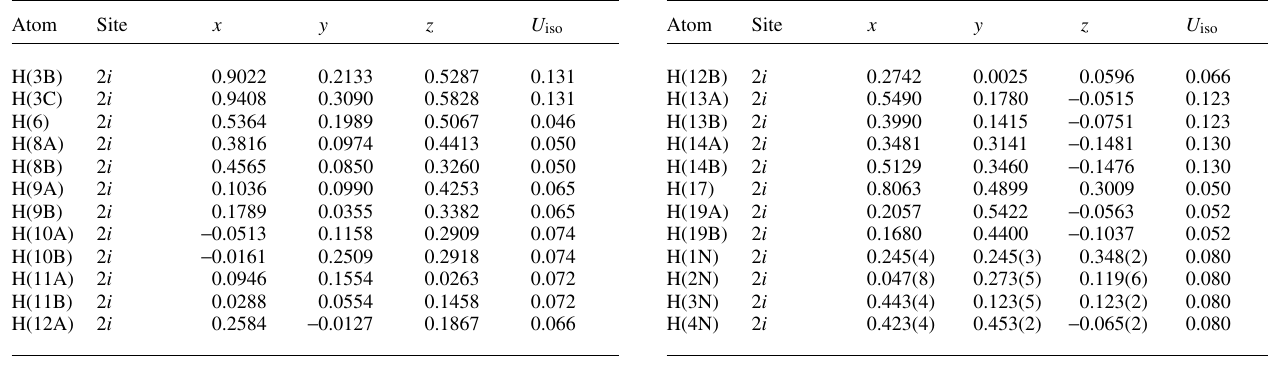
Table 3. Atomic coordinates and displacement parameters (in Å 2 )